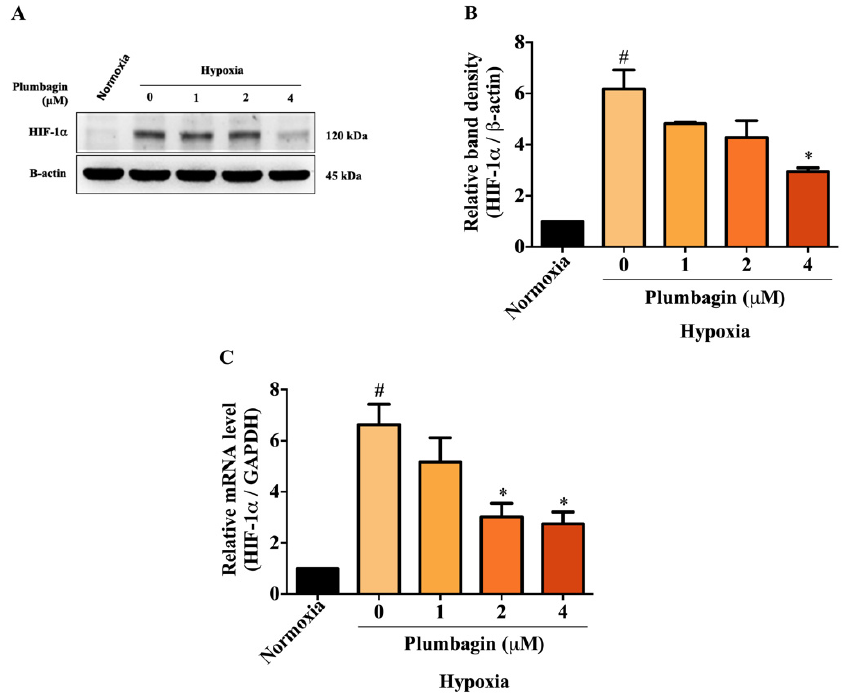
Figure 4. Plumbagin suppressed HIF-1 α at transcriptional and translational levels under CoCl 2 -induced hypoxic conditions in MCF-7 cells. ( A ) HIF-1 α protein expression was analyzed by Western blotting. MCF-7 cells were treated with 0–4 µ M of plumbagin for 24 h under hypoxic conditions induced by CoCl 2 . ( B ) The relative quantities of HIF-1 α protein were quantified and normalized with β -actin. ( C ) Plumbagin downregulated HIF-1 α gene expression. Data are means ± SEM from three independent experiments ( n = 3). # p < 0.05 vs. normoxic, * p < 0.05 vs. mimic hypoxic group without treatment.